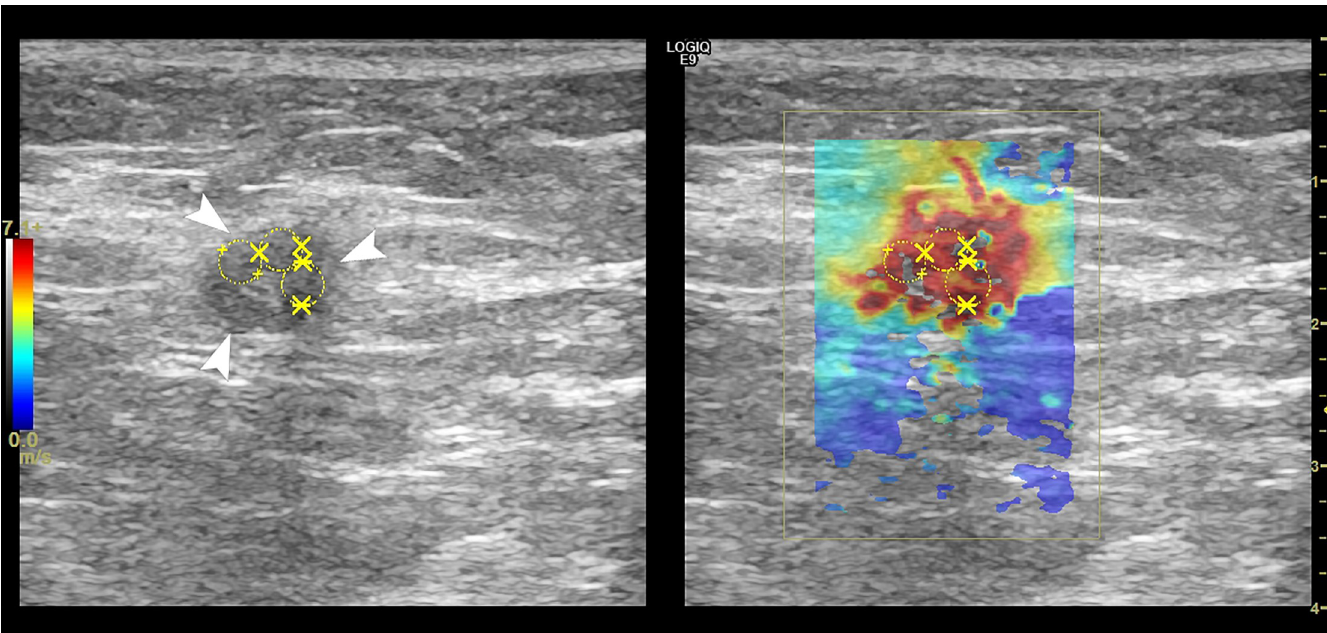
Fig 6. Left axillary US B-mode (left) and shear wave speed map (right) images in a 76-year-old woman with an infiltrating ductal carcinoma (grade II) in the left breast. The US image demonstrates a round, enlarged lymph node (white arrows) measuring 1.2 x 0.9 x 1.0-cm. The elasticity results calculated from the average of the 3 ROIs (yellow) were E mean = 129.0-kPa and E max = 268.7-kPa. FNA biopsy revealed metastatic adenocarcinoma involving fibroadipose tissue.